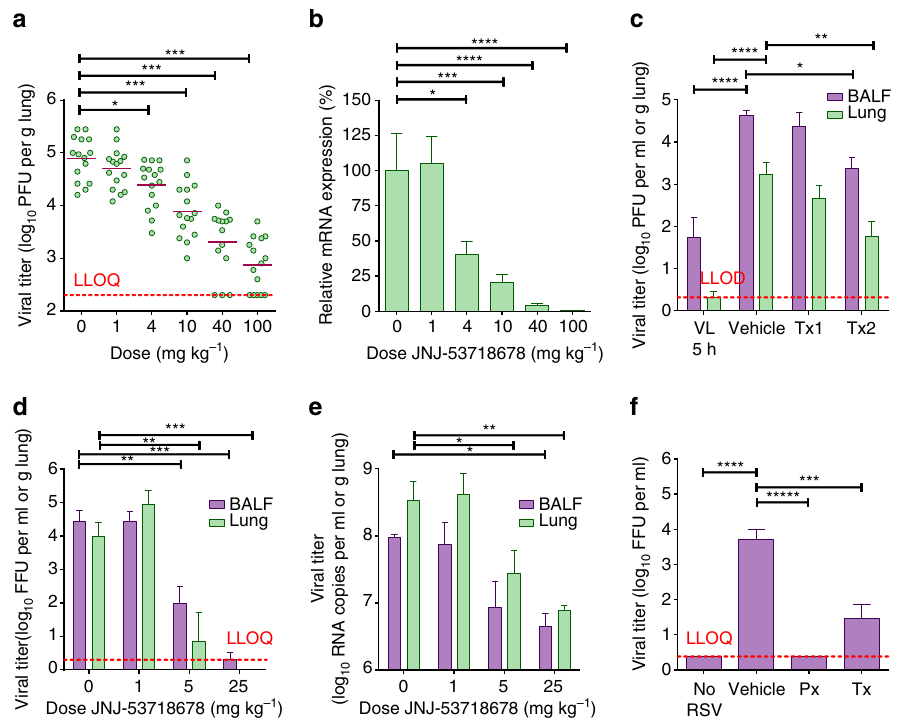
Fig. 4 Administration of RSV fusion inhibitors reduces infection in animal models. a Dose-dependent inhibition of infectious RSV titer in lavaged-lung tissue of male, 6 – 8-week-old infected cotton rats treated with a single dose of JNJ-53718678 1 h before infection. Shown on the graphs are the individual data points measured ( green circles ); bars represent mean values ( n = 15). b Relative dose-dependent inhibition of RSV mRNA expression in lung tissue of male, 6 – 8-week-old infected cotton rats treated with a single dose of JNJ-53718678 1 h before infection. mRNA expression in cotton rats treated with different single doses of JNJ-53718678 was calculated relative to the vehicle-treated animals (set as 100 %). Green bars represent average values + s.e.m. ( n = 15). c Inhibition of the infectious RSV titer in BALF ( purple bars ) and lavaged-lung tissue ( green bars ) of 5 – 15-week-old infected cotton rats of both sexes treated with a single dose (Tx1; n = 4) or multiple once-daily doses (Tx2; n = 10) of 40 mg kg − 1 JNJ-53718678 starting 24 h after infection. Titers of compound- treated animals were compared to the titers in animals treated with vehicle only (vehicle; n = 9) on Day 4 after infection. As a positive control for viral growth in the lungs of animals in the absence of treatment with JNJ-53718678, RSV titers were determined in BALF and lavaged-lung tissue at 5 h after intranasal inoculation (VL 5 h; n = 10) and compared to the titers on Day 4. Bars represent average values + s.e.m. d , e Inhibition of the infectious RSV titer d and RSV viral RNA levels e in BALF ( purple bars ) and lavaged-lung tissue ( green bars ) of 1 – 3-day-old infected neonatal lambs of both sexes treated once daily with 1 ( n = 4), 5 ( n = 3), or 25 ( n = 3) mg kg − 1 of JNJ-53718678 or with vehicle only (0; n = 3) as indicated on the x -axis. Bars represent average values + s.e.m. f Treatment-dependent inhibition of infectious RSV titer in BALF of 1 – 3-day-old infected neonatal lambs of both sexes treated once daily with 25 mg kg − 1 JNJ-49214698 starting 24 h before (Px; n = 4)) or 72 h after infection (Tx; n = 5) and compared to the titer in vehicle only-treated ( n = 4) or non-infected ( n = 5) animals. Red dotted line indicated the lower limit of quanti fi cation (LLOQ) or detection (LLOD) of the respective assays. Statistical analysis in all panels was performed by one-way ANOVA followed by Dunnett ’ s post hoc. * p -value < 0.05, ** p < 0.01, *** p < 0.001, **** p <